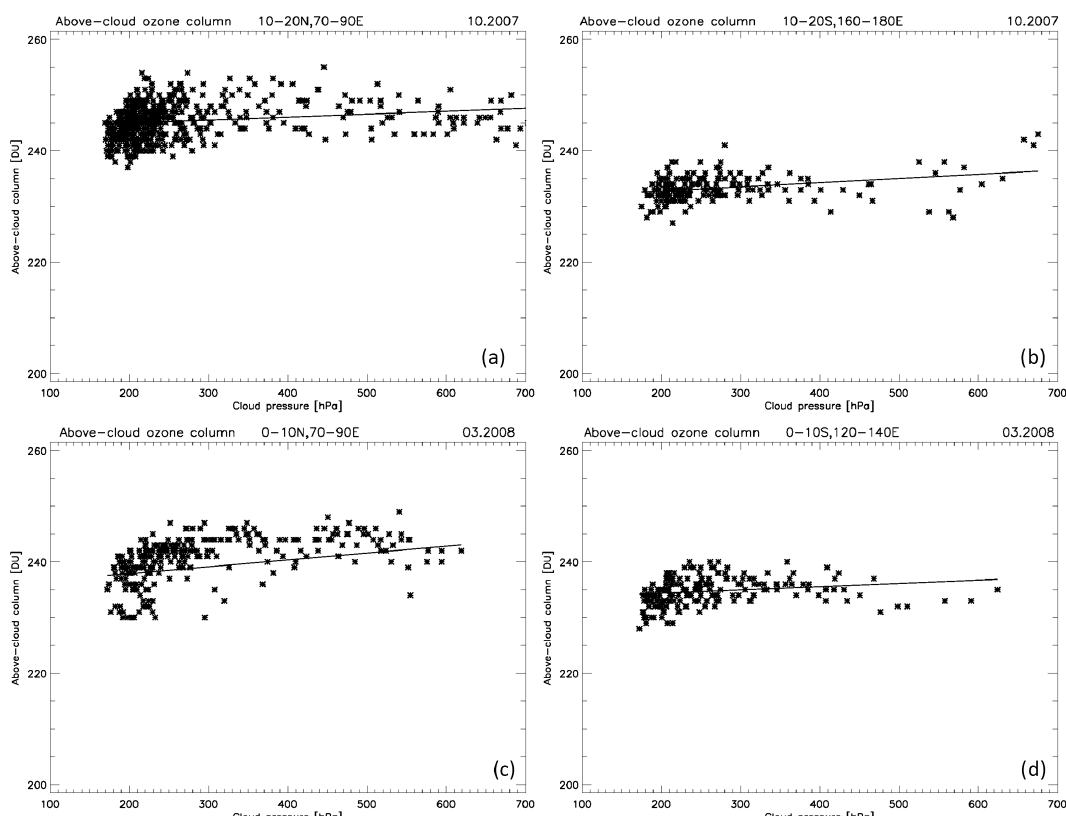
Figure 4. Scatter plot of the GOME-2 ozone column above highly reflective clouds (cloud albedo ≥ 0.75) as a function of the GOME-2 cloud- top pressure (as provided by ROCINN) for 1–3 October 2007 (top) and 1–3 March 2008 (bottom). The regions are: 10–20 ◦ N / 70–90 ◦ E (a) , 10–20 ◦ S / 160–180 ◦ E (b) , 0–10 ◦ N / 70–90 ◦ E (c) and 0–10 ◦ S / 120–140 ◦ E (d) . From the regression fittings, mean ozone concentrations of 4–7ppbv are found in the middle-to-upper troposphere of these